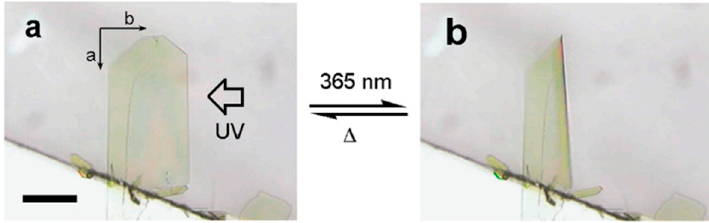
Figure 3. Photomechanical bending of a thin crystal of trans - 1 ( a ) before and ( b ) after ultraviolet (UV) irradiation. The irradiation was conducted from the right rear side of the crystal, as indicated by the arrow. The scale bar is 200 µm. Reprinted with permission from [26]. Copyright 2009 American Chemical Society.